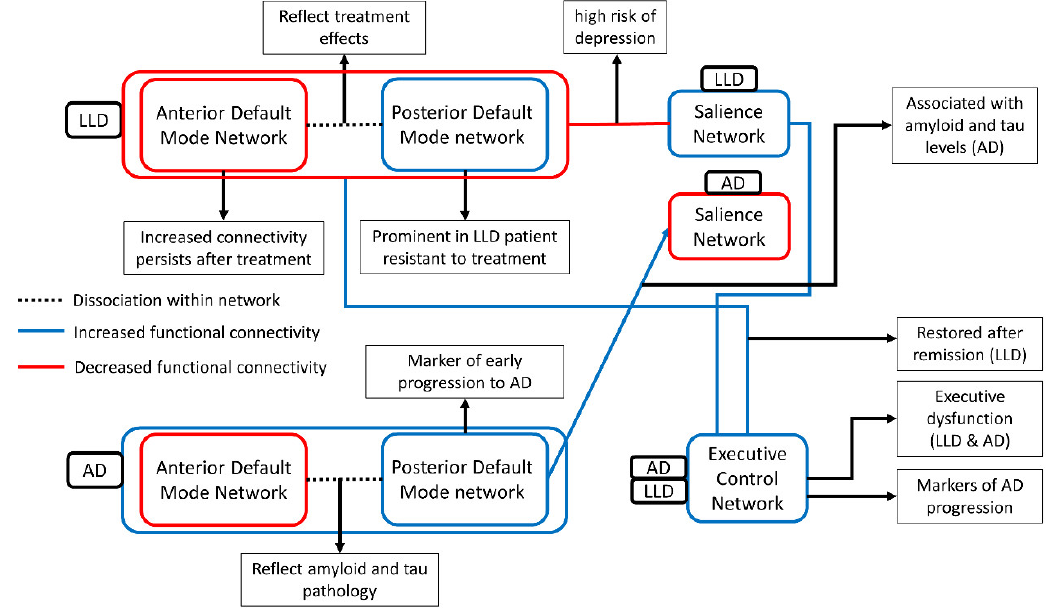
Figure 1. The figure presents the aberrant functional connectivity between three networks in AD and LLD and its clinical implication. Blue line and red line indicate the decreased functional connectivity and the increased functional connectivity compared with healthy control, respectively. Decreased functional connectivity of the executive control network was commonly observed in AD and LLD [192,197]. In contrast, the functional connectivity of the salience network and the default mode network were differently altered. The default mode network connectivity decreased in AD and increased in LLD [93,127], and the salience network increased in AD and decreased in LLD [130,215]. However, dissociated functional connectivity pattern in DMN, increased in the anterior DMN and decreased in the posterior DMN, was commonly observed in both AD and LLD [96,166]. This dissociation reflects treatment effects in LLD and amyloid/tau pathology in AD [100,165]. This similarity of dissociation seems to be a possible mechanism of association between LLD and AD highlighted in epidemiological studies.